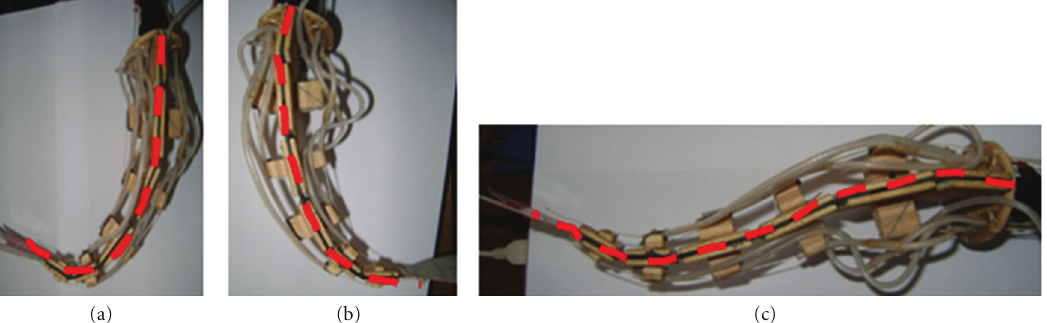
Figure 28: Static view of the tail bending left (a), bending right (b), and making a swimming shape (c).